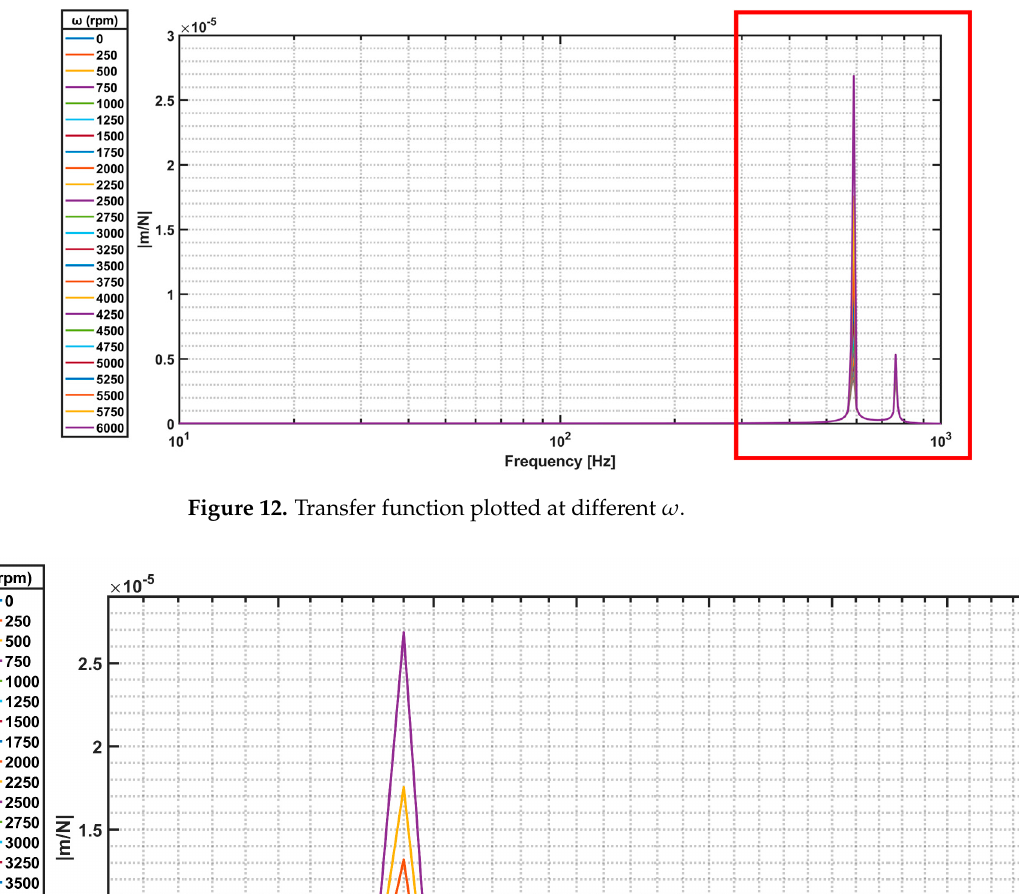
Figure 12. Transfer function plotted at different (cid:2033) .